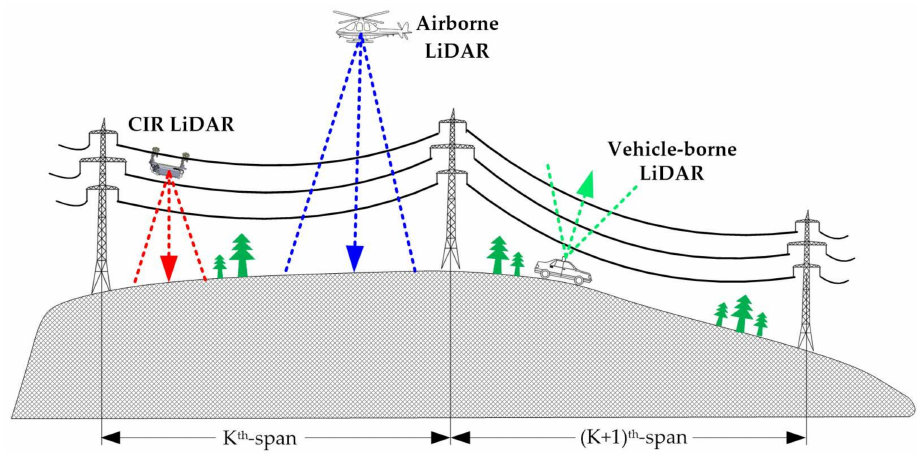
Figure 3. Schematic diagrams of work principles of three LiDAR